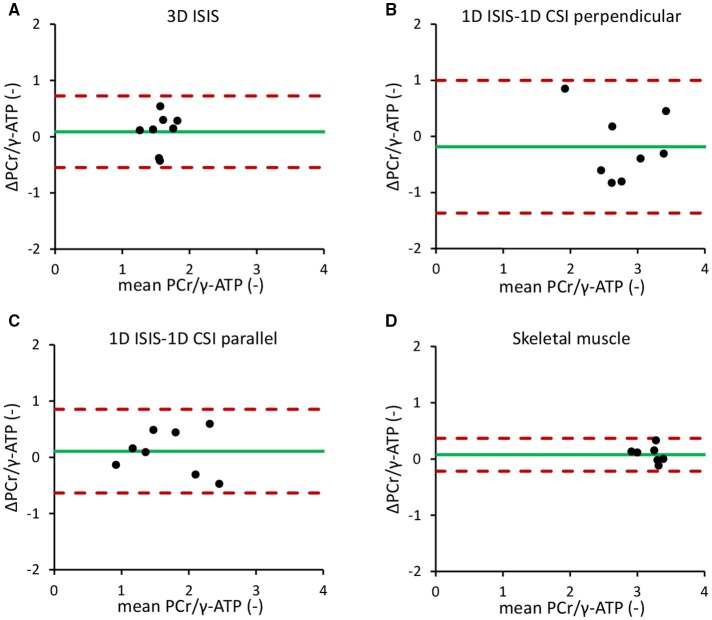
Bland-Altman repeatability analyses of localized 31P-MRS measurements of the in vivo myocardial PCr/γ-ATP ratio. (A) 3D ISIS of the human heart. (B) 1D CSI in a 1D ISIS-selected slice perpendicular to the surface coil. (C) 1D CSI in a 1D ISIS-selected slice parallel to the surface coil. (D)
31P-MRS of the human calf muscle. Dotted red lines indicate the 1.96 × SD limits of the difference between two measurements in the same subject (repeatability coefficient) around the mean difference (green solid line). ATP, adenosine triphosphate; CSI, chemical shift imaging; ISIS, image-selected in vivo spectroscopy; PCr, phosphocreatine.